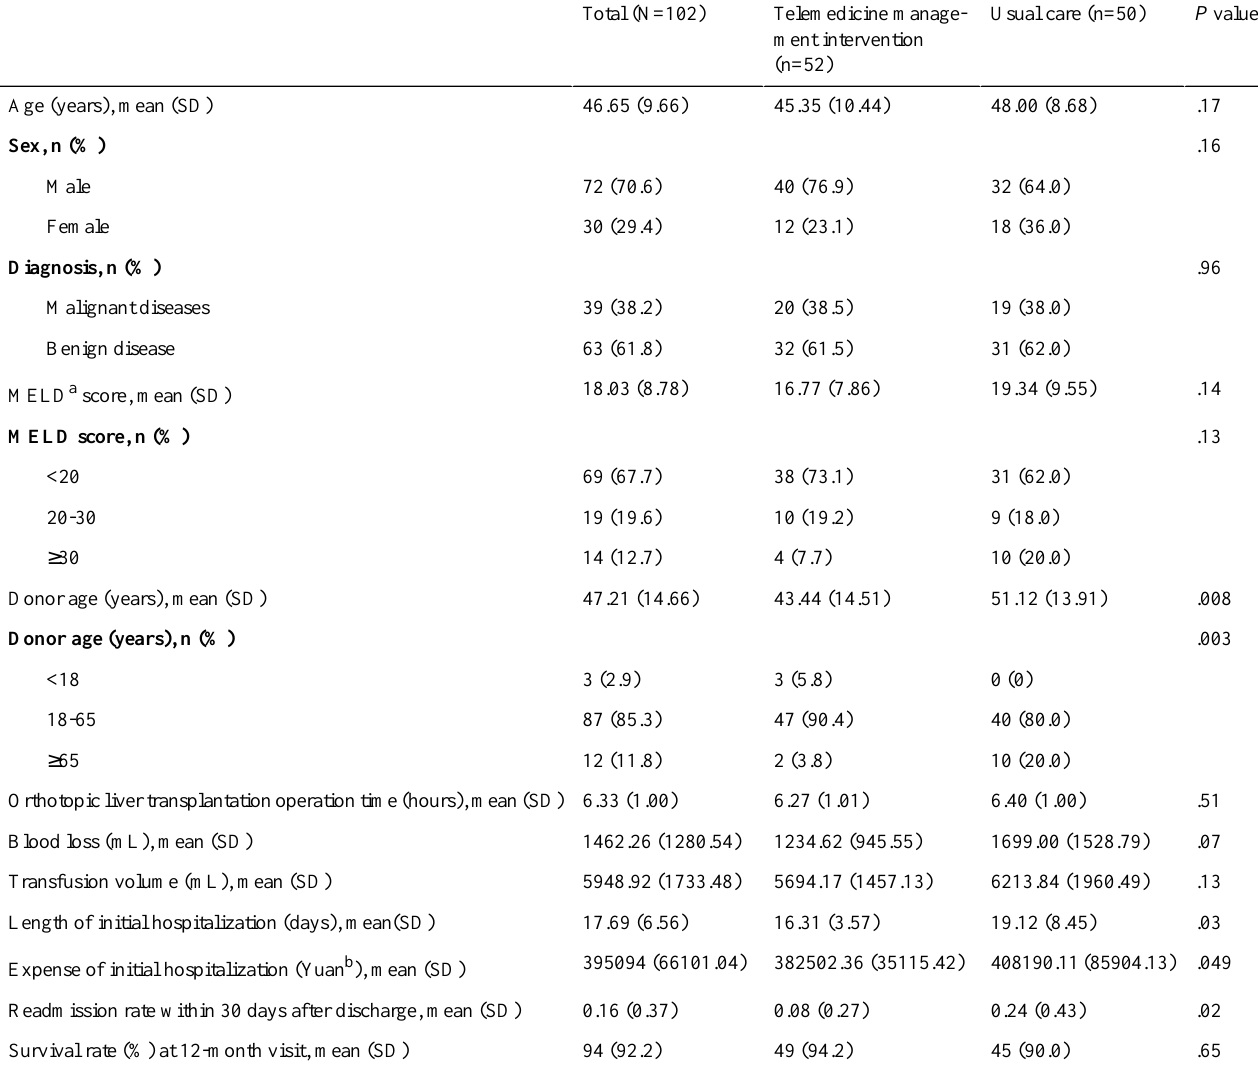
Table 1. Baseline